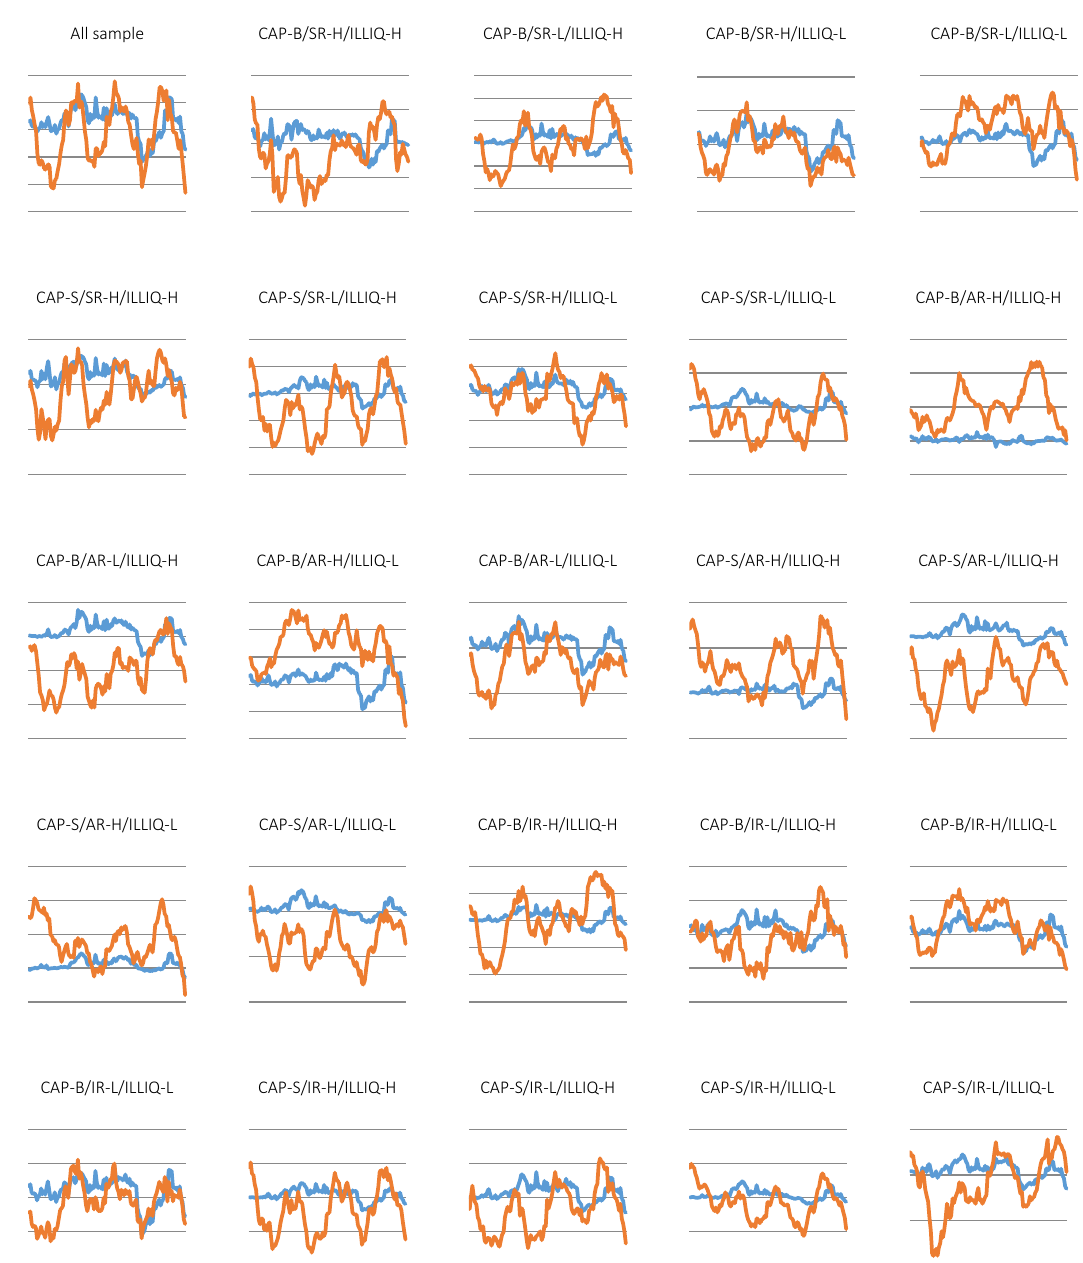
Figure 1. Comparison trend line of expected returns and actual